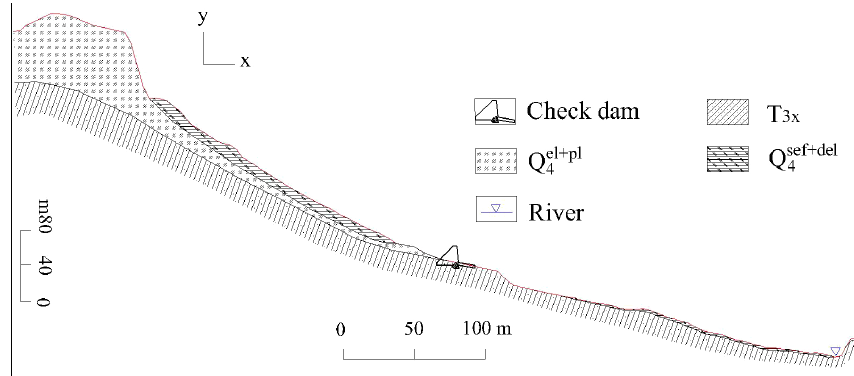
Figure 2. The strata profile of the Guojuanyan gully (Jun Wang et al.,